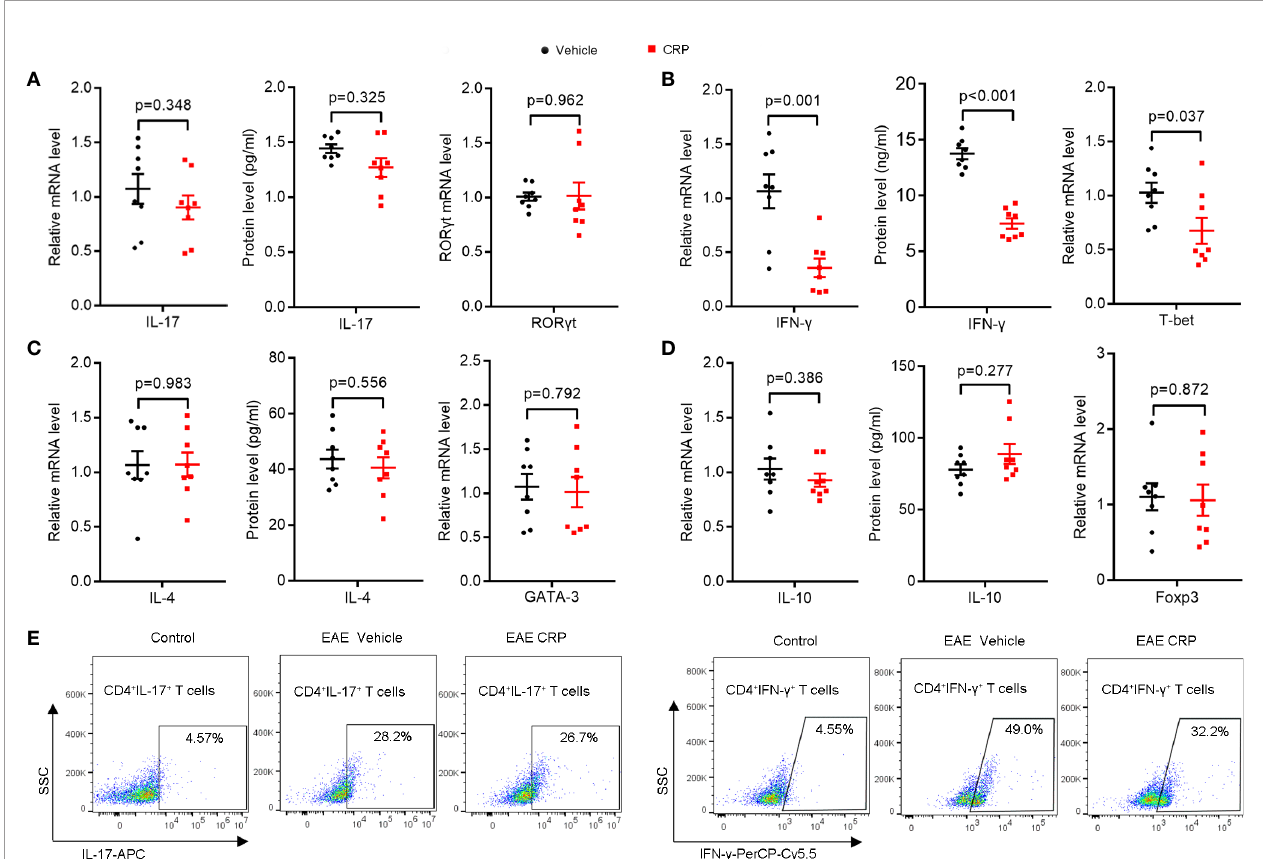
FIGURE 4 | The decrease in Th17 response disappeared in Fc g R2B − / − EAE mice with CRP injection. (A) qPCR and ELISA analysis of IL-17 and ROR g t expression in splenocytes and CD4 + T cells from Fc g R2B − / − EAE mice and Fc g R2B − / − EAE CRP (n = 8). (B) qPCR and ELISA analysis of IFN- g and T-bet expression in splenocytes and CD4 + T cells from Fc g R2B − / − EAE mice and Fc g R2B − / − EAE CRP (n = 8). (C) qPCR and ELISA analysis of IL-4 and GATA-3 expression in splenocytes and CD4 + T cells from Fc g R2B − / − EAE mice and Fc g R2B − / − EAE CRP (n = 8). (D) qPCR and ELISA analysis of IL-10 and Foxp3 expression in splenocytes and CD4 + T cells from Fc g R2B − / − EAE mice and Fc g R2B − / − EAE CRP (n = 8). (E) Flow cytometry analysis of Th17 (CD4 + IL-17 + ) and Th1 (CD4 + IFN- g + ) cells by cell surface and intercellular staining from Fc g R2B − / − EAE mice and Fc g R2B − / − EAE CRP (n = 3). Data are presented as mean ± SEM; p < 0.05 was considered statistically signi fi